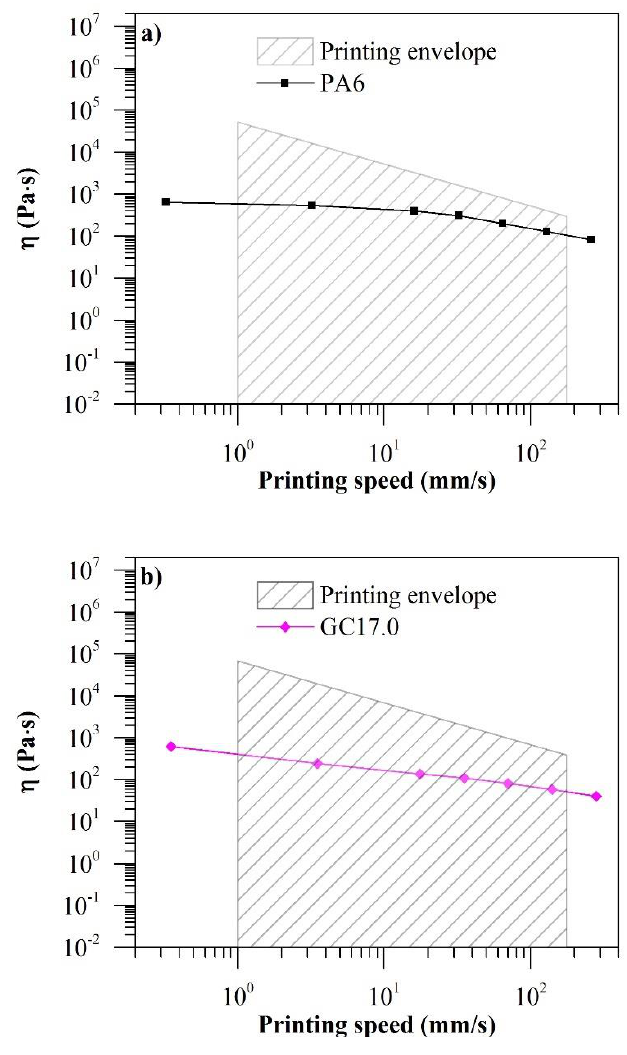
Figure 8. Printing envelope of ( a ) PA6 and ( b ) GC17.0 for printing speeds between 1 and 175 mm/s.